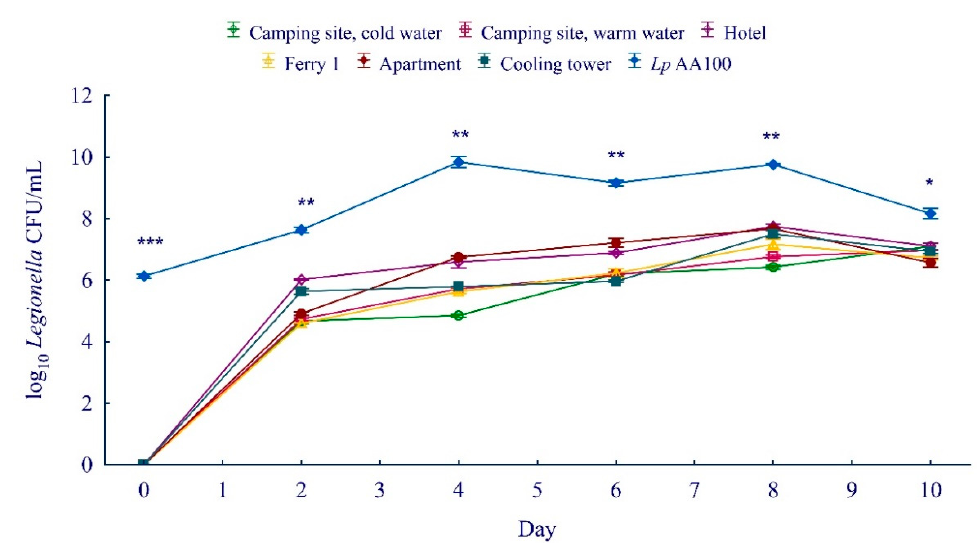
Figure 6. The growth kinetics of environmental L. pneumophila in A. castellanii during 10-day period. L. pneumophila AA100 was used as control. Student’s t -test, * p < 0.05, ** p < 0.01, *** p < 0.001 were accepted as significantly different from control sample.